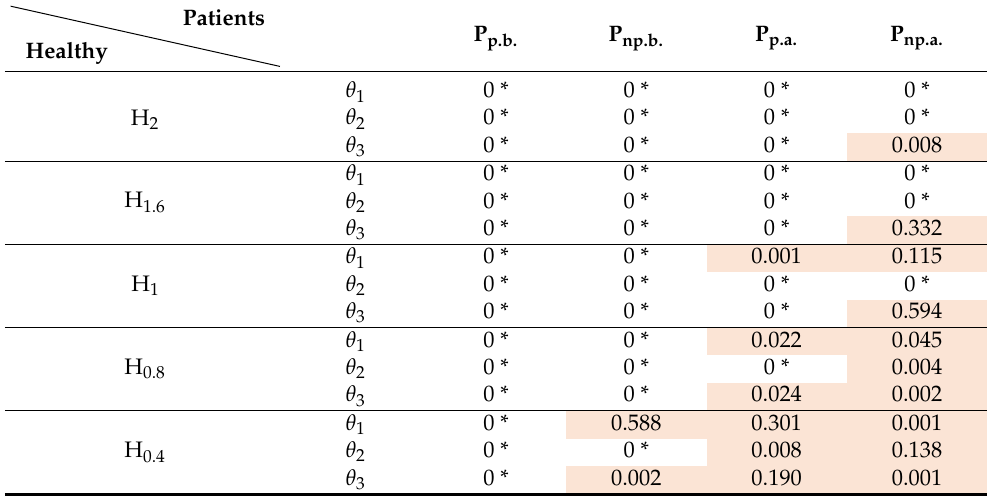
Table 4. Statistical differences between healthy and patient groups (before and after therapy).